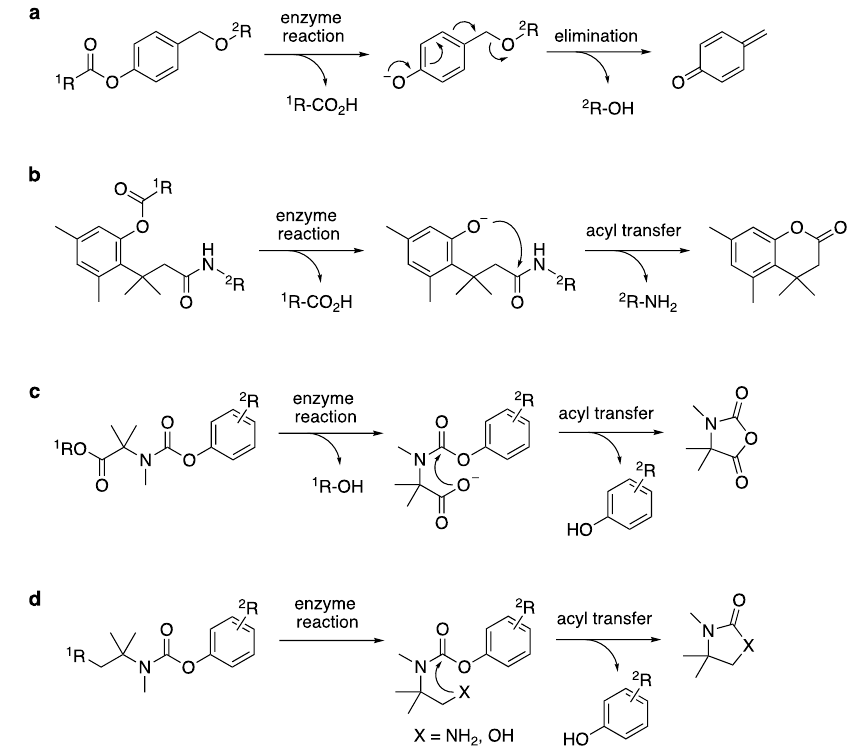
Figure 1. Activation mechanisms of self-immolative linkers: ( a ) 1,6-elimination to form quinone methide, ( b ) acyl transfer of trimethyl lock, and ( c , d ) acyl transfer of the trimethyl carbamate developed in this study.